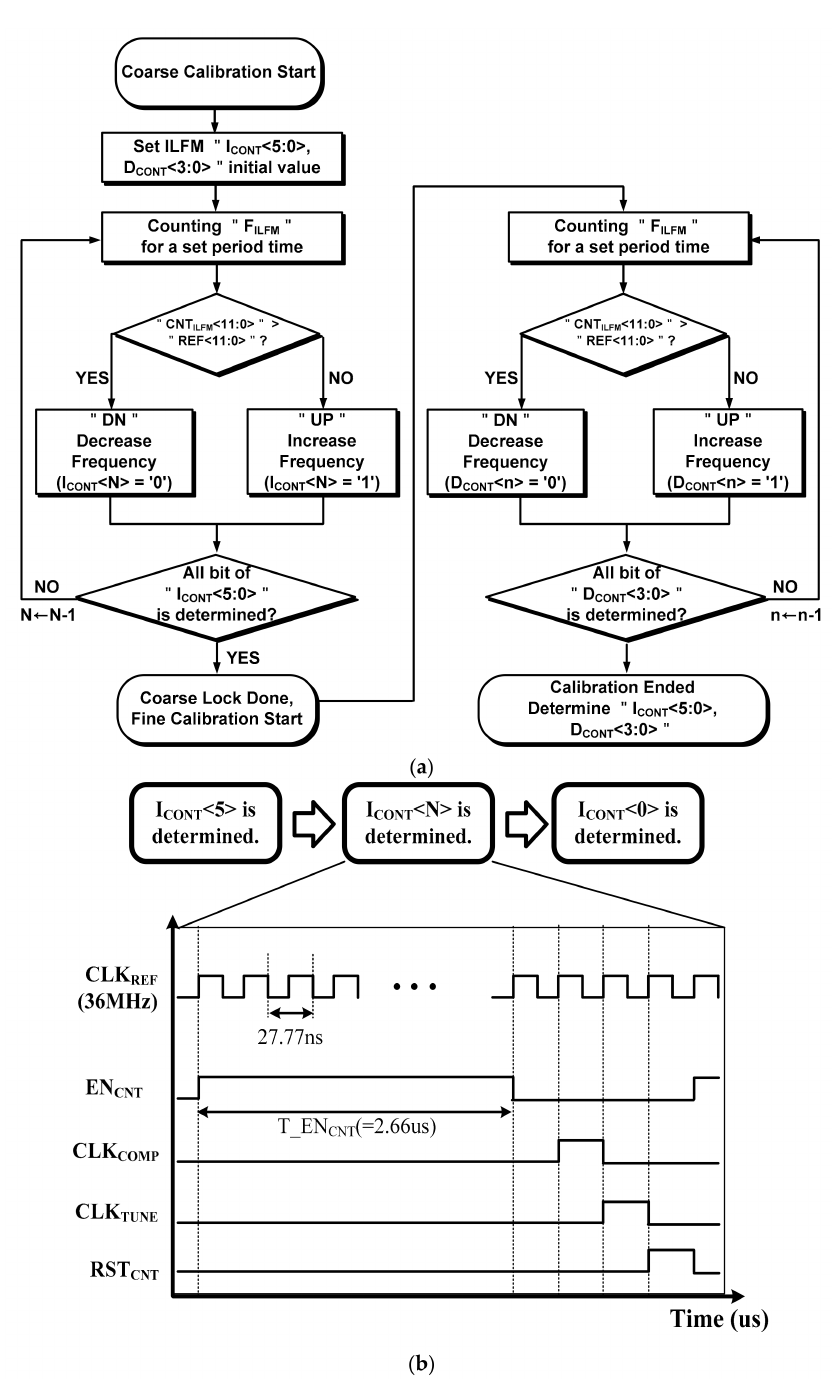
Figure 7. ( a ) Flow chart of Frequency Calibration Logic and ( b ) timing diagram of 1-state of FSM in Frequency Calibration